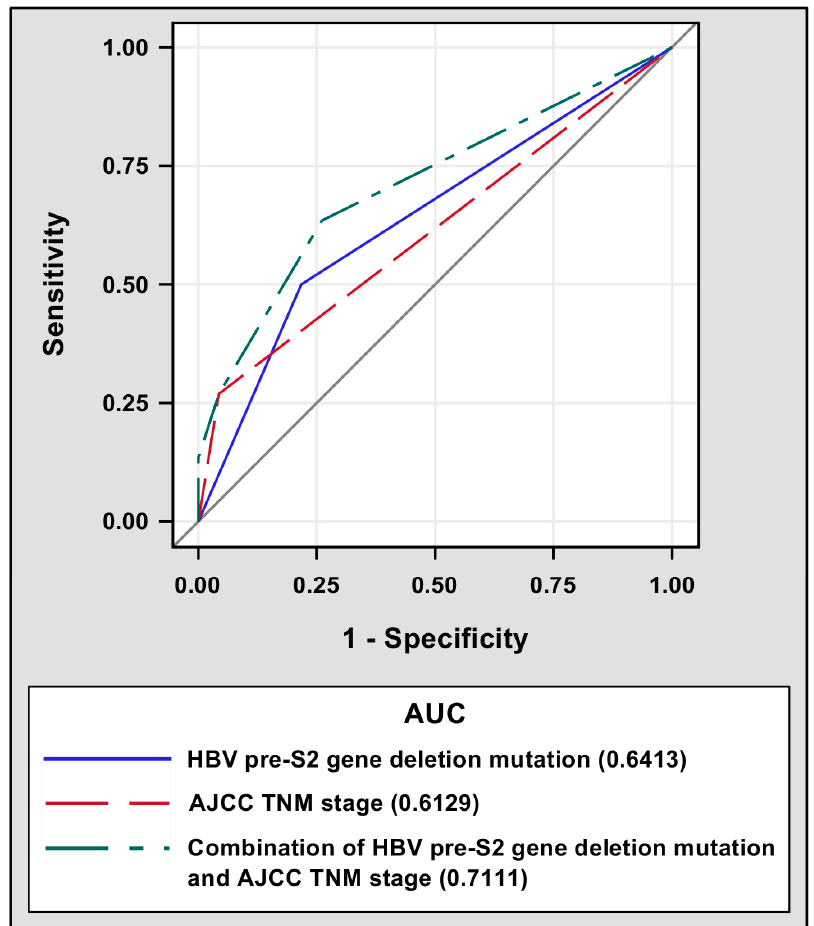
Figure 2. ROC curves for comparing the performance of HBV pre-S2 gene deletion mutation and/or AJCC TNM stage in predicting HCC recurrence after curative surgical resection. 52 patients with HCC recurrence and 23 patients without HCC recurrence were analyzed. The AUC for pre-S2 gene deletion mutation (solid blue line), AJCC TNM stage (dotted red line) or combination of both factors (dotted green line) was shown at the bottom of the plot. Table 4. Univariate and multivariate RFS analyses of HBV pre-S2 gene deletion mutation combined with AJCC TNM stage in 75 HBV-related HCC patients.